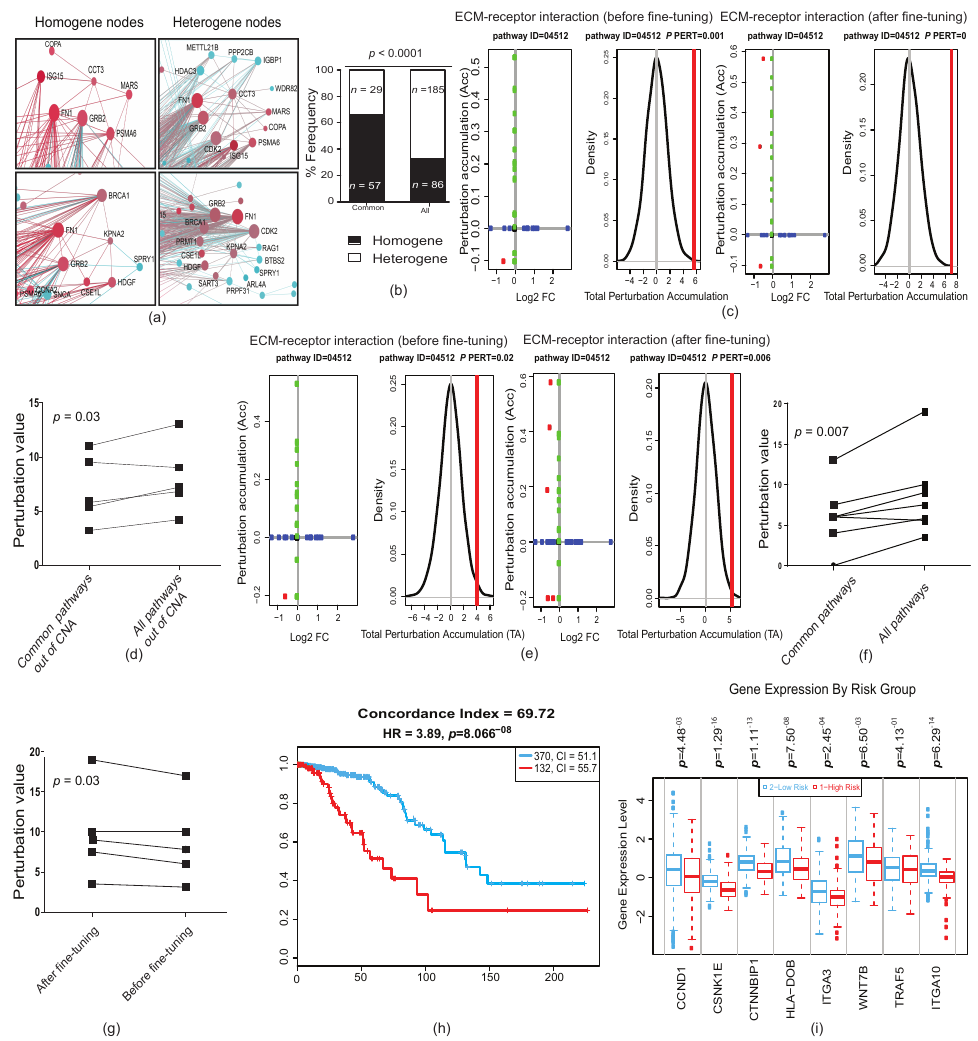
Figure 5. Forward and backward evolution and fine-tuning concept. ( a ) Examples of the direction of changes in homogene and heterogene nodes; ( b ) homogeneity and heterogeneity statistical analysis for common and all (all DEG3) networks; ( c ) examples of signaling pathway impact analyses (SPIA) for analyses of common SGAs and all DEG3 (common + disparate) outside of CNAs (see Table S7). In this plot, the horizontal axis represents the p -value (minus log of) corresponding to the probability of randomly obtaining at least the observed number of genes (NDE) on the given pathway. The vertical axis represents the p -value (minus log of) corresponding to the probability of randomly obtaining the observed total accumulation (tA) or more extreme on the given pathway. Unchanged genes were assigned 0 log2 fold-change. The null distribution of the net accumulated perturbations is also given (right panel). The observed net accumulation tA is shown as a red vertical line (see [28]). ( d ) Evaluation of perturbation between common SGAs and all DEG3-SGAs outside of CNAs. Note that the numbers represent the pure changes of perturbation compared to the Table S7, which shows negative perturbation values for the inhibition of pathways and positive perturbation values for the activation of pathways. ( e ) Examples of SPIA analyses of common SGAs and all DEG3; ( f ) evaluation of perturbation between common SGAs and all DEG3-SGAs; ( g ) evaluation of perturbation between enriched pathways for all DEG3-SGAs before adding the eight backward-evolution genes and after adding backward-evolution genes; ( h , i ) survival analyses for eight backward-evolution genes ( h ). The direction of backward-evolution genes was in the direction of the good-prognosis samples ( i ). Evaluation p -values in ( d , f , g ) were calculated using a paired Student’s t -Test, and in ( b , k , l ) using a chi-square